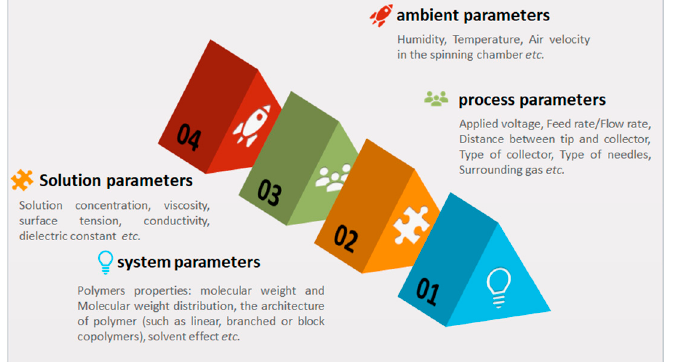
Figure 9. Classification of the main parameters influencing the electrospinning process, adapted from reference [48] .